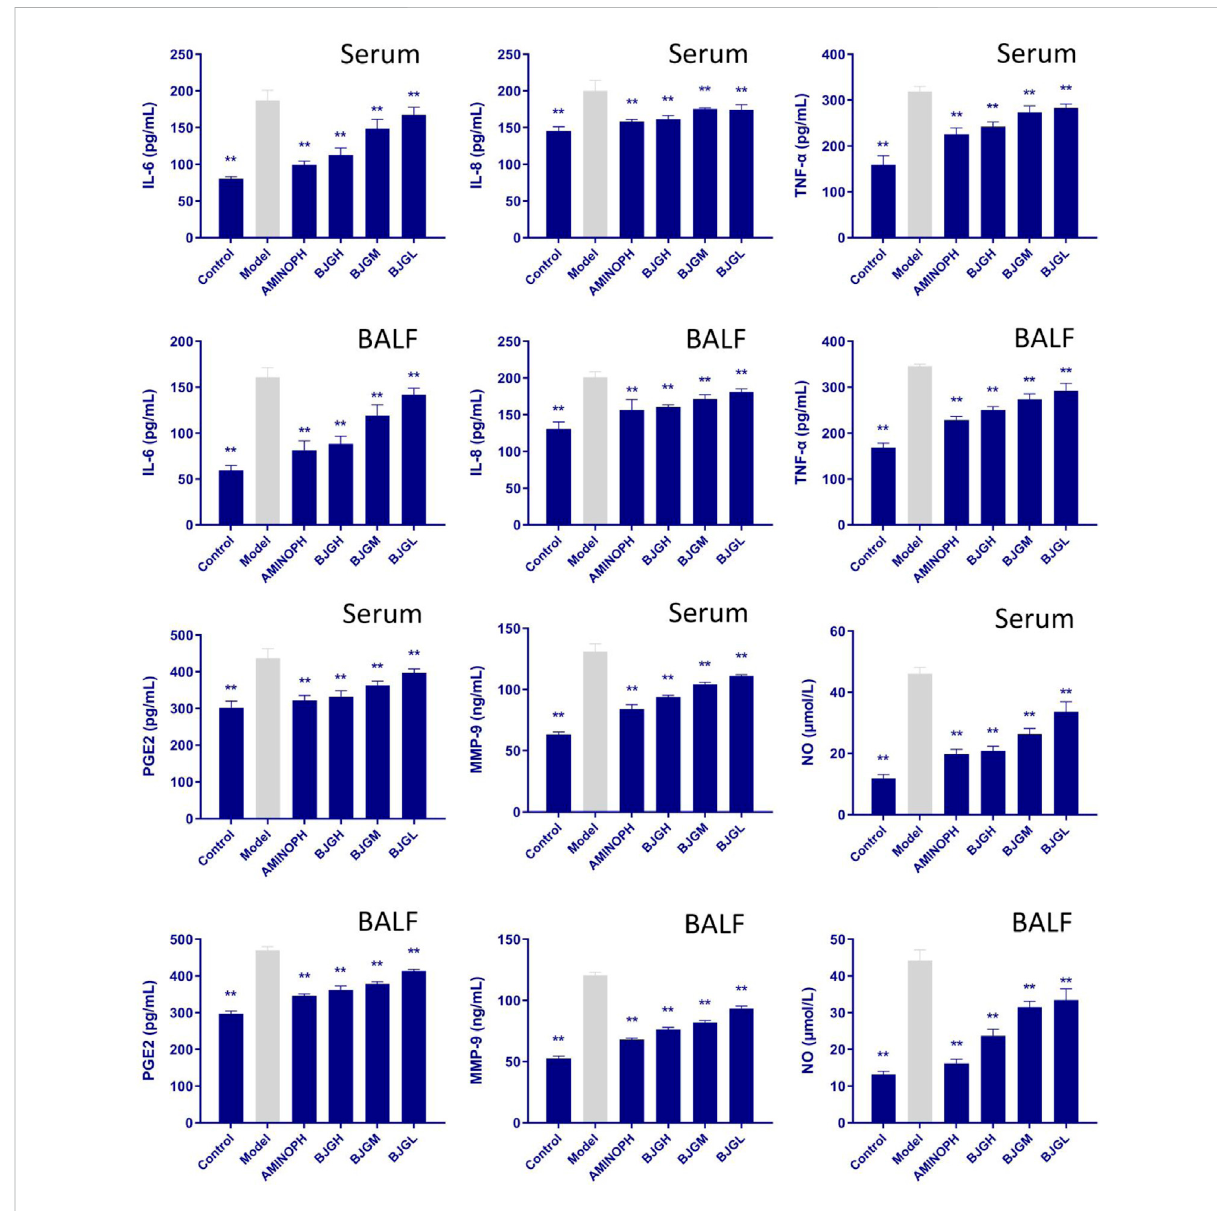
FIGURE 4 Changes in in fl ammatory factors in the rat serum and